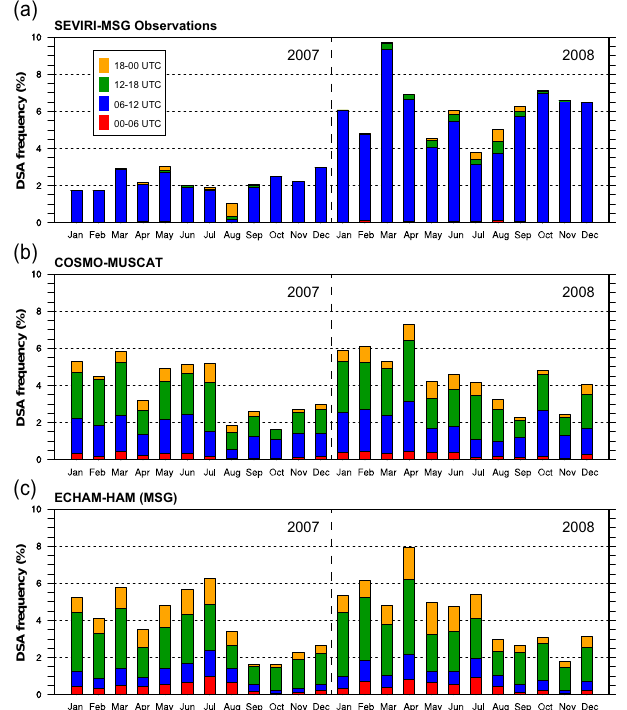
Figure 7. Monthly totals of sub-daily frequencies of Saharan dust source activations for the years 2007 and 2008. The emission events were derived from (a) the MSG infrared dust index and dust com- putations with (b) the regional dust model COSMO-MUSCAT and (c) the ECHAM-HAM model using the MSG-based source